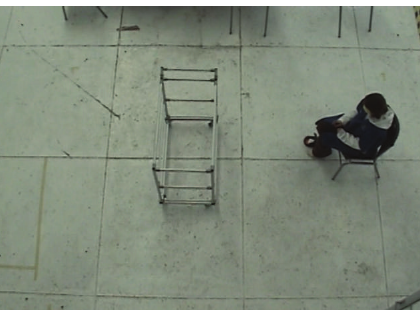
Figure 9: Situational awareness assistance during